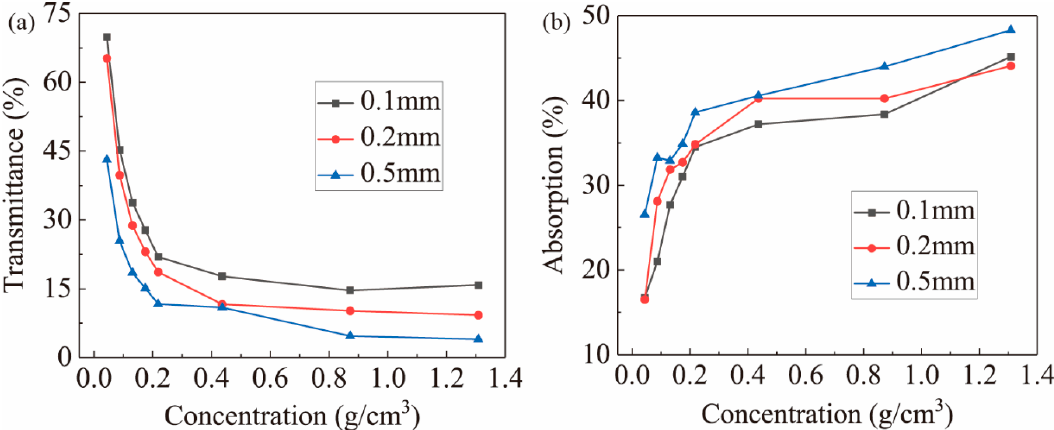
Figure 8. Results of multi-particle method simulation under an incident light of 445 nm. ( a ) The change of transmittance with different concentrations and thickness films. ( b ) The change of absorption with different concentrations and thickness films.